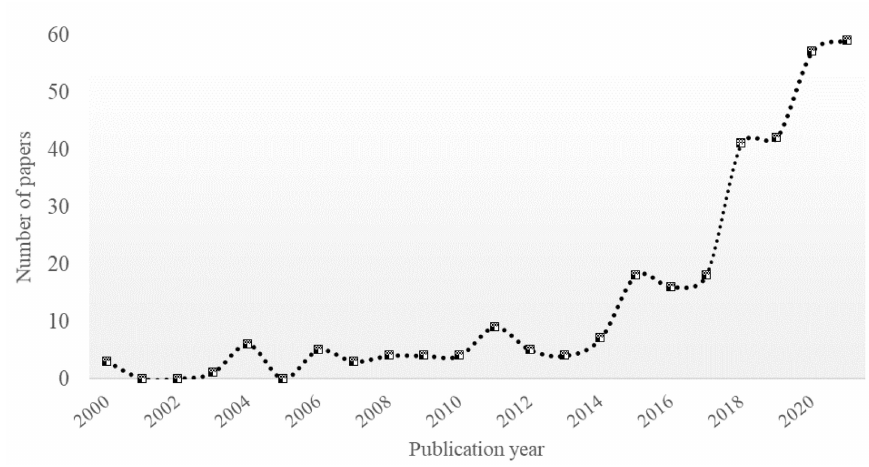
Figure 1. The statistics of the publication year of 306